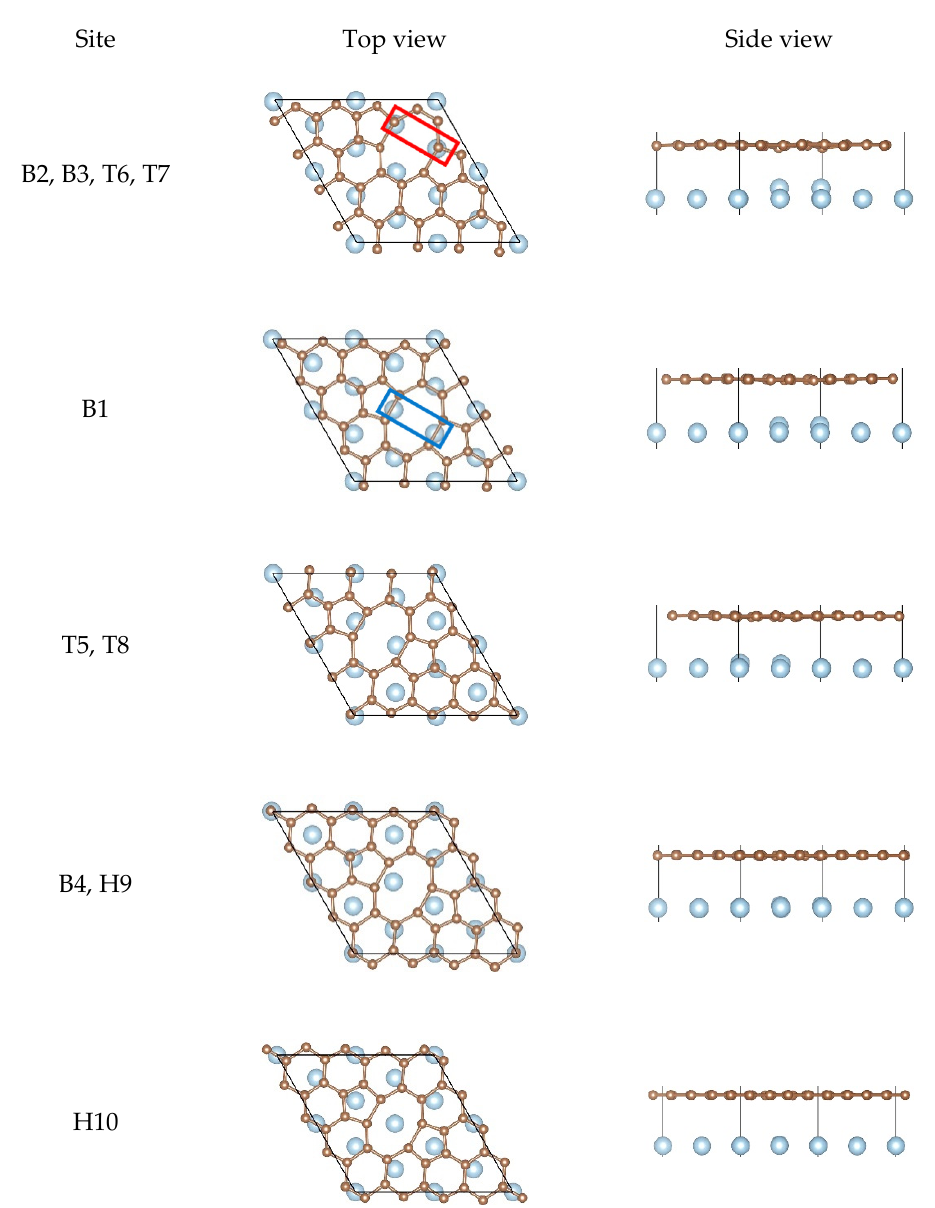
Figure 5. Top views and side views of the DV graphene on the Al (111) surface after the structural optimization. For the pristine graphene/Al (111) interface in Figure 2, there was hardly any change in the relative positions between the carbon atoms and the Al atoms from the top views and there was almost no buckling of the graphene sheet and the topmost layer of Al from the side views. However, the equilibrium interlayer distance d C − Al increased significantly compared to the initial interfacial distance. These results show that the interfacial bonding strength between the pristine graphene and the Al (111) surface was weak. When it comes to the SW defect graphene/Al (111) interface, there are two kinds of equilibrium configurations found, as shown in Figure 3. For the first equilibrium configuration, we found that most Al atoms lay below carbon atoms and other Al atoms were located at the center of hexagon rings. In addition, we could observe that there was distinct buckling of the graphene sheet and the topmost layer of Al from the side views, especially where the carbon atoms were in contact with the Al atoms at the defect. However, for the second equilibrium configuration, it was clearly found that there were two Al atoms located at the center of two heptagon rings. Moreover, B C was obvious but B Al was